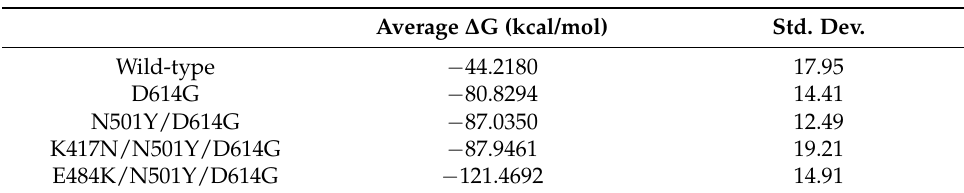
Table 1. The binding free energies calculated from molecular dynamics (MD) simulations for the spike/ACE2 interactions of SARS-CoV-2.